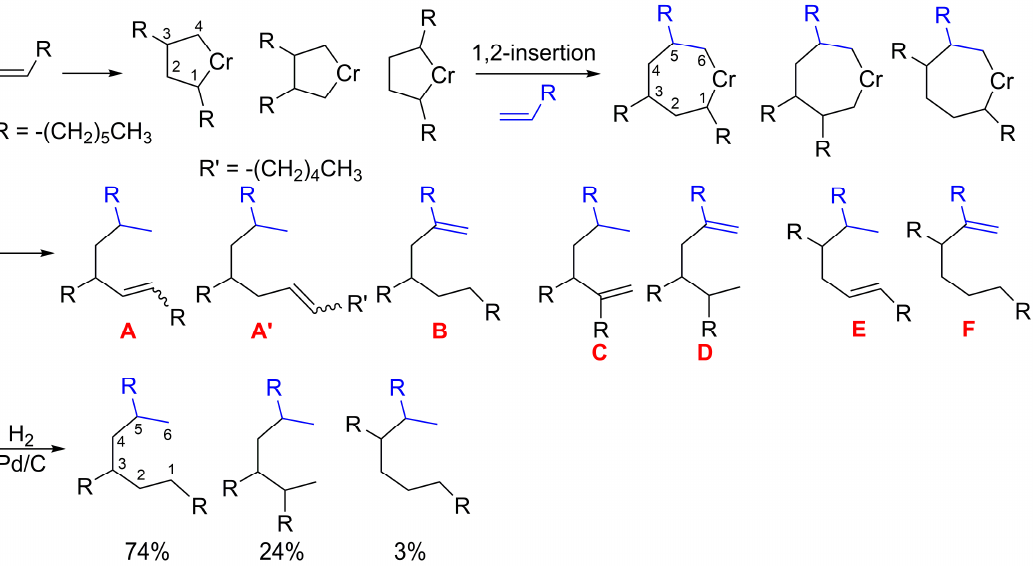
Scheme 1. Rationale for the observed trimer isomer distribution.